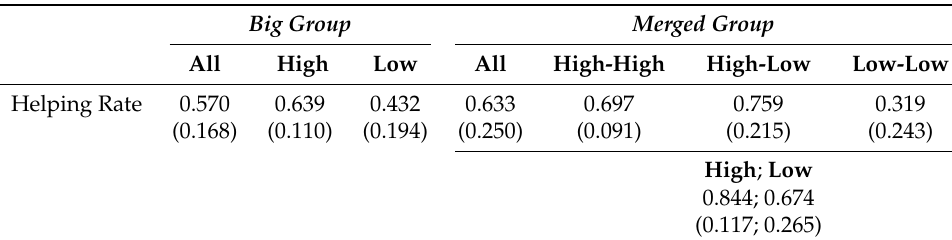
Table 3. Average helping rate and average group payoff in Part B by treatment and sub-group Big Group All Helping